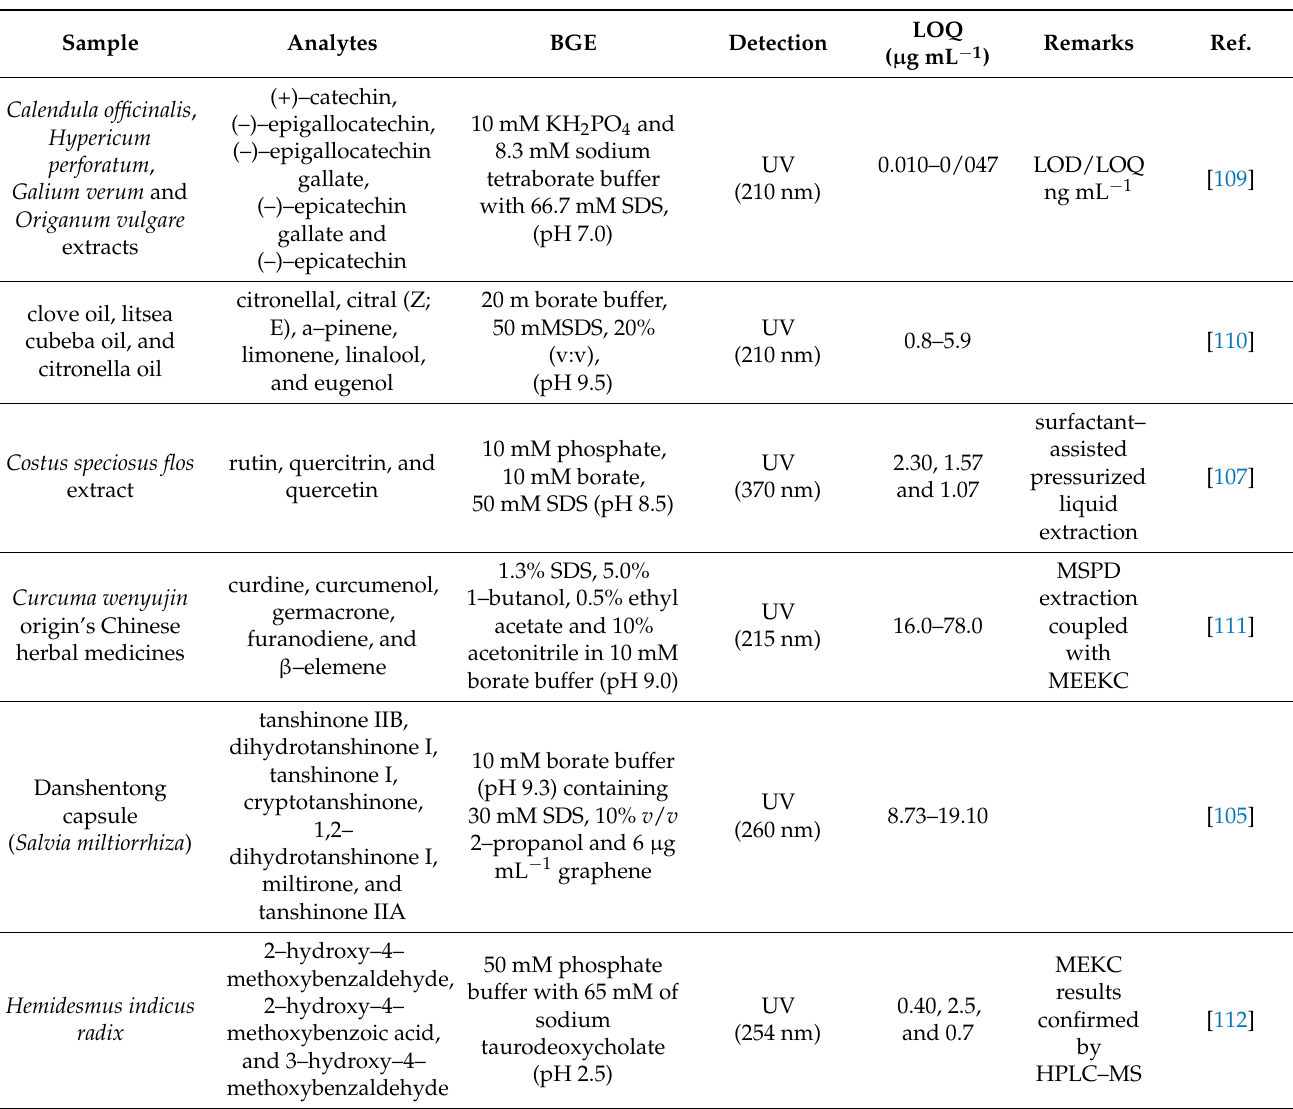
Table 2. Application of micellar electrokinetic chromatography and microemulsion electrokinetic chromatography.